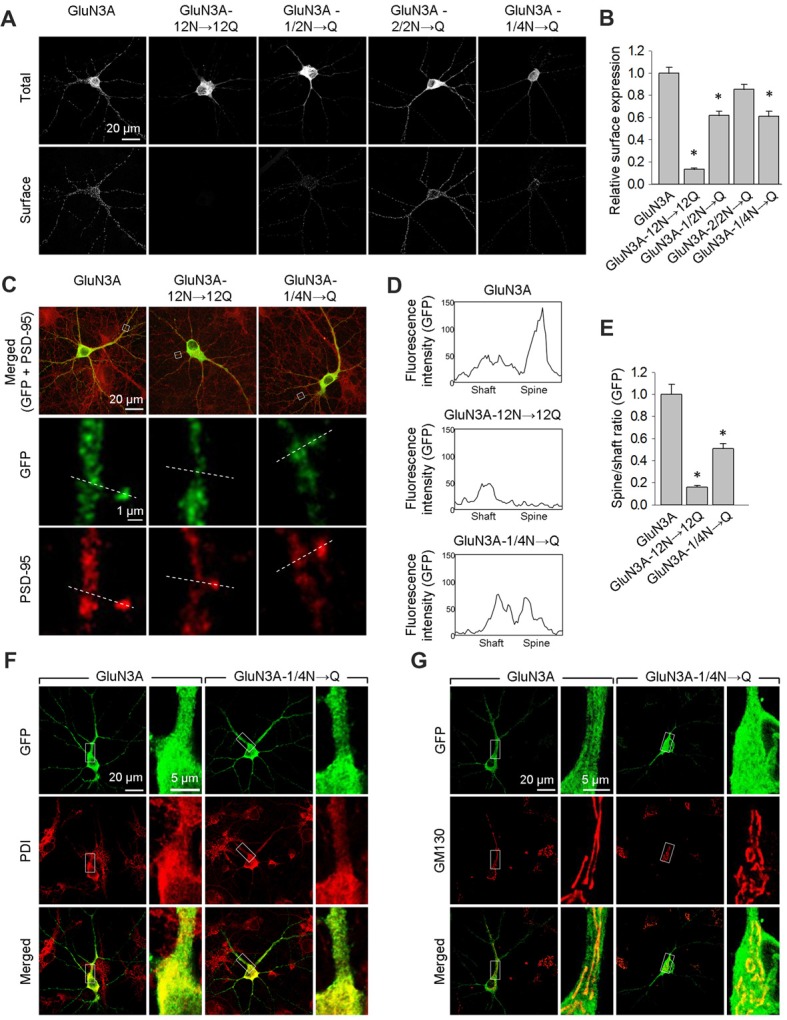
The GluN3A-1/4N→Q subunit has reduced surface expression in hippocampal neurons. (A) At days in vitro (DIV)10, cultured hippocampal neurons were transfected with the indicated GFP-GluN3A (GluN3A) subunits; at DIV14, the cells were immunostained for surface and total GFP under non-permeabilizing and permeabilizing conditions, respectively. Representative images of total and surface immunoreactivity are shown. (B) Summary of the relative surface expression of the indicated GluN3A subunits obtained from 10-μm long segments of secondary and tertiary dendrites (n ≥ 36 segments from ≥12 neurons for each GluN3A subunit); *p < 0.05 vs. wild-type GluN3A (ANOVA). (C–E) Cultured hippocampal neurons were transfected with the indicated GluN3A subunit at DIV10; at DIV14, the cells were immunostained under permeabilizing conditions using anti-GFP and anti-postsynaptic density protein 95 (PSD-95) antibodies; PSD-95 staining was used to visualize the dendritic spines.  (C) Representative images of neurons showing co-localization between GFP and PSD-95 immunoreactivity in cells transfected with indicated the GluN3A subunits. The dashed lines were used to generate line plots for a spine and an adjacent dendritic shaft for GFP (middle row) and PSD-95 fluorescence (bottom row). (D) Representative graphs of the intensity of the GFP signal in a dendritic shaft and spine of neurons transfected with the indicated GluN3A subunits. (E) Summary of the ratio of spine/shaft fluorescence intensity calculated from the peak fluorescence intensity measured in spine and shaft pairs (n = 30 spines from ≥5 neurons for each GluN3A subunit); *p < 0.05 vs. GluN3A (ANOVA). There was no significant difference between the wild-type and mutant GluN3A with respect to GFP intensity in dendritic shafts (data not shown). (F,G) Hippocampal neurons were transfected with the indicated GluN3A subunits on DIV10; at DIV14, the cells were immunostained for the endoplasmic reticulum (ER) marker protein disulfide isomerase (PDI; F) or the GA marker Golgi matrix protein (GM130; G).